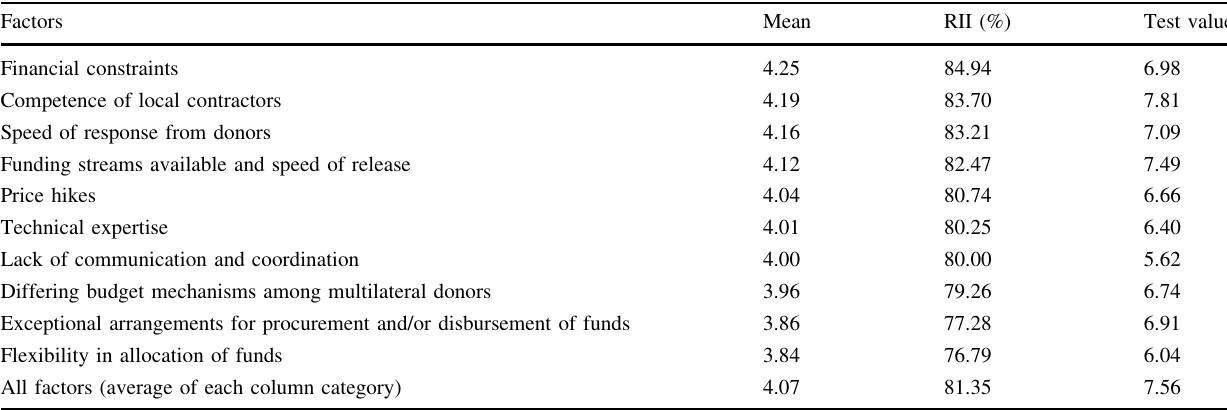
Table 4 Factors influencing project funding in the Gaza Strip Factors